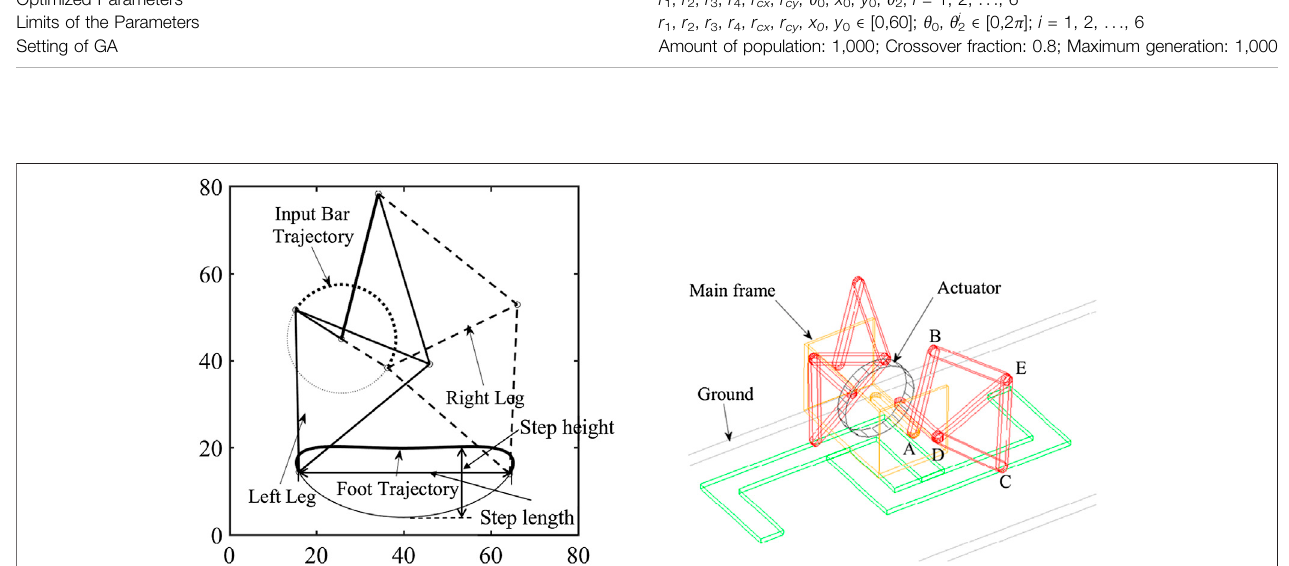
FIGURE 4 | Leg trajectory of the optimized four-bar mechanism and schematic representation of the robot with this mechanism.